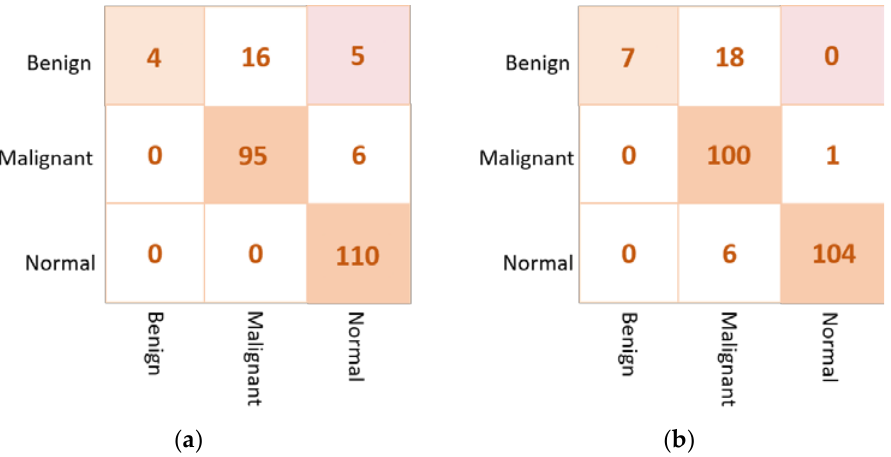
Figure 15. Confusion matrix of the proposed AI models for the multi-class classification approach on real dataset: ( a ) the Ensemble learning model ( b ) the proposed ETECADx.